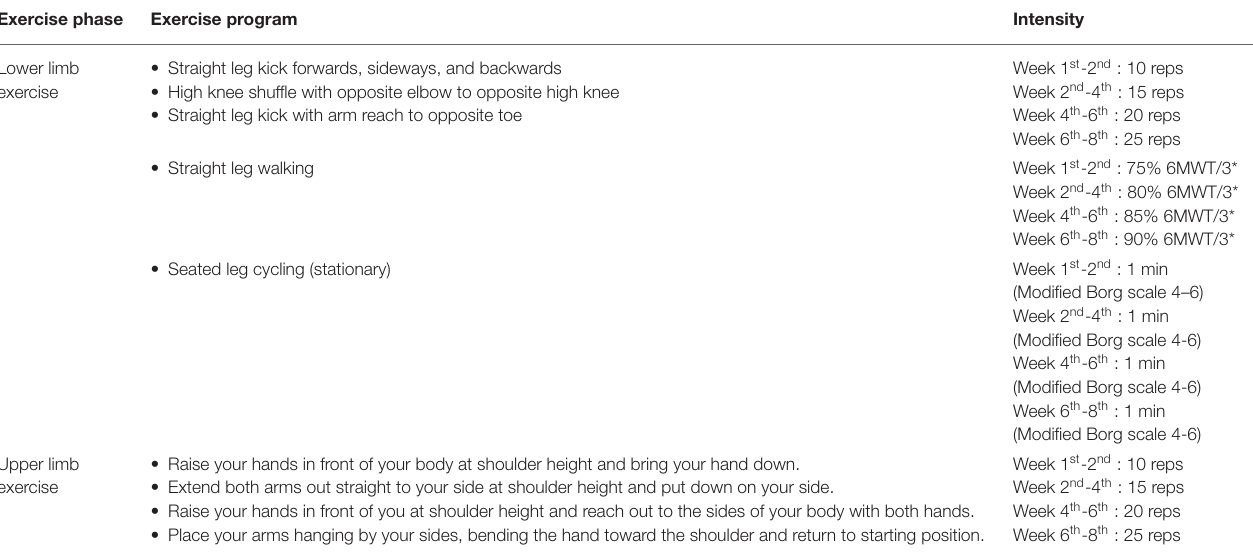
TABLE 2 | Progression of exercise program for land-based and water-based exercise group (12). Exercise